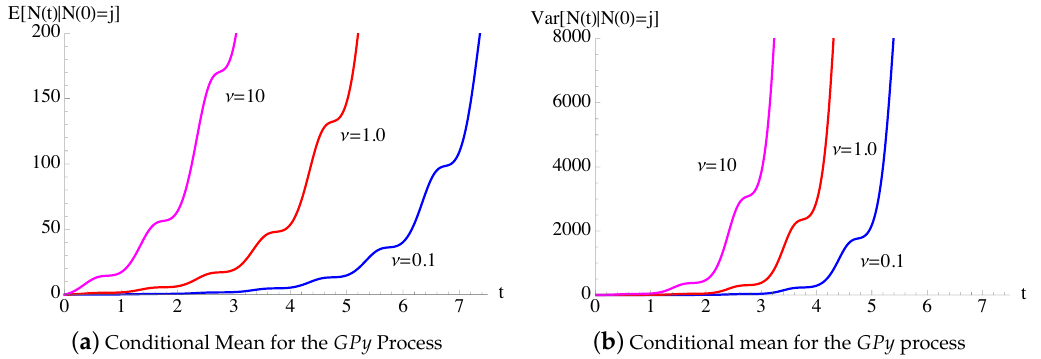
Figure 10. For the GPy process of Figure 9, the conditional mean and the conditional variance (53) are plotted as function of t for j = 0, λ = 1.0, a = 0.9, Q = 1.0 and for some choices of ν